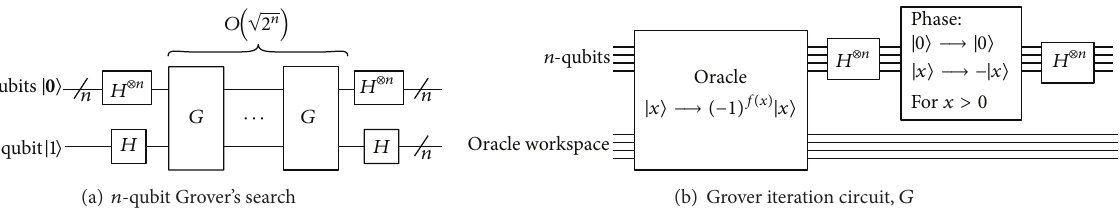
Figure 5: Quantum circuit model for Grover’s search algorithm [33].